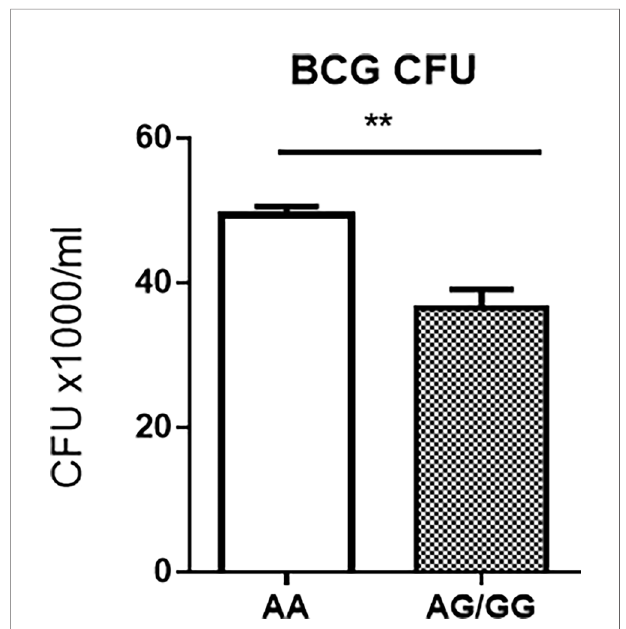
FIGURE 3 | Host PBMC expressing the rs1053005 AA genotype and low constitutive stat3 exhibited the reduced ability to mount fast-acting innate immunity against mycobacterial infection in cellular models. The graph shows that mean BCG CFU counts in co-cultures of BCG-infected A549 cells and PBMC isolated from uninfected HC expressing the stat3 SNP AA genotype and low stat3 were signi fi cantly higher than those displaying the AG (25 subjects) or GG (AG/GG, 42 subjects) genotype. The isolated PBMC were co-cultured for 3 days with BCG-infected A549 cells (6 h of MOI = 10) at the 10:1 ratio of PBMC: A549, and then the lysates of the co-cultures were assessed for BCG CFU counts. The co-culture system allowed us to minimize BCG-uptake/infection variations among tested individuals and to assess fast- acting innate immunity against mycobacterial infection in cellular models (see Results / Discussion ). Data are means ± standard errors. **P <